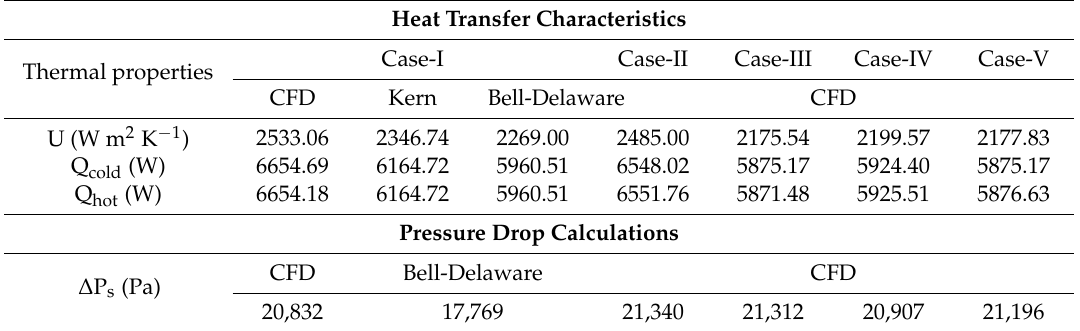
Table 7. Results of numerical and analytical calculations for all cases.